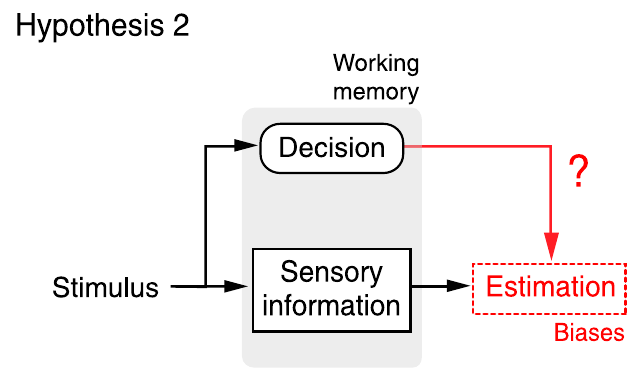
Fig 1. Origins of post-decision estimation biases. Are choice-induced estimation biases the result of a modified sensory representation in working memory (Hypothesis 1) or rather of a computational inference process downstream (Hypothesis 2)? We run psychophysical experiments in which subjects had to reverse their categorical decision if incorrect according to feedback. Under Hypothesis 1, traces of the first (incorrect) decision should be visible in subjects’ estimates.